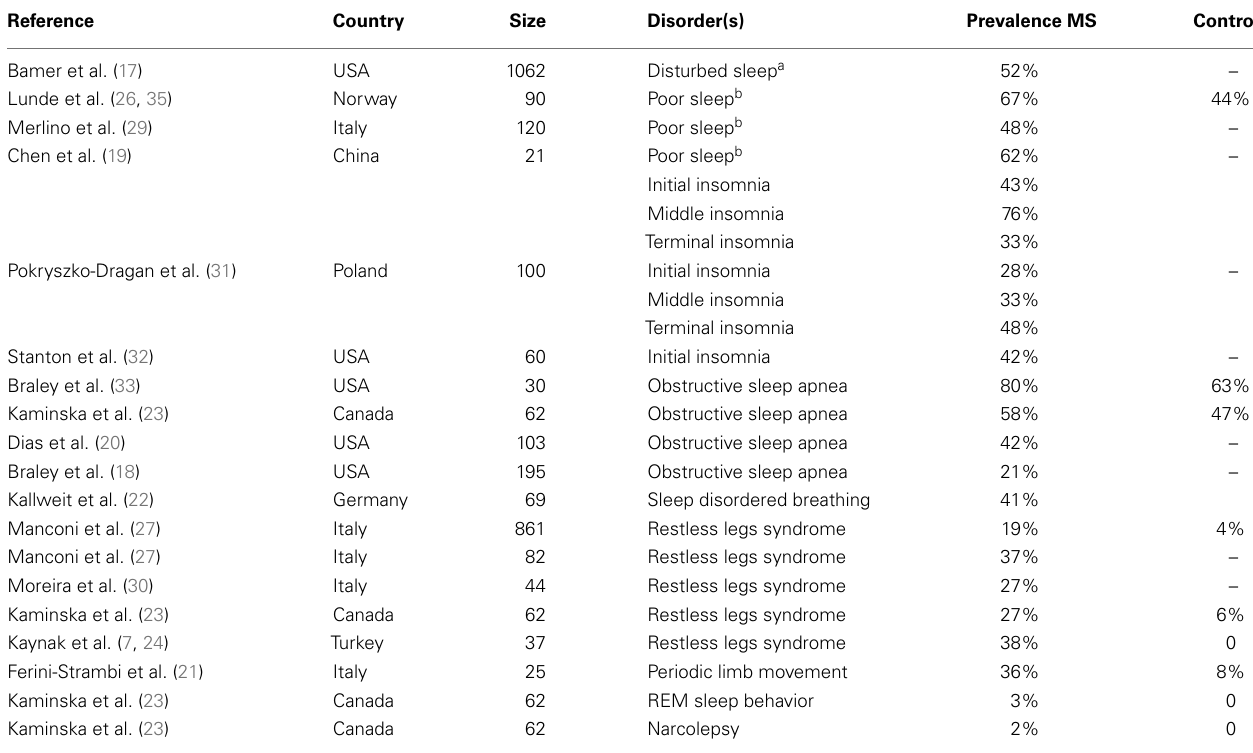
Table 1 | Prevalence of sleep disorders in multiple sclerosis (MS)